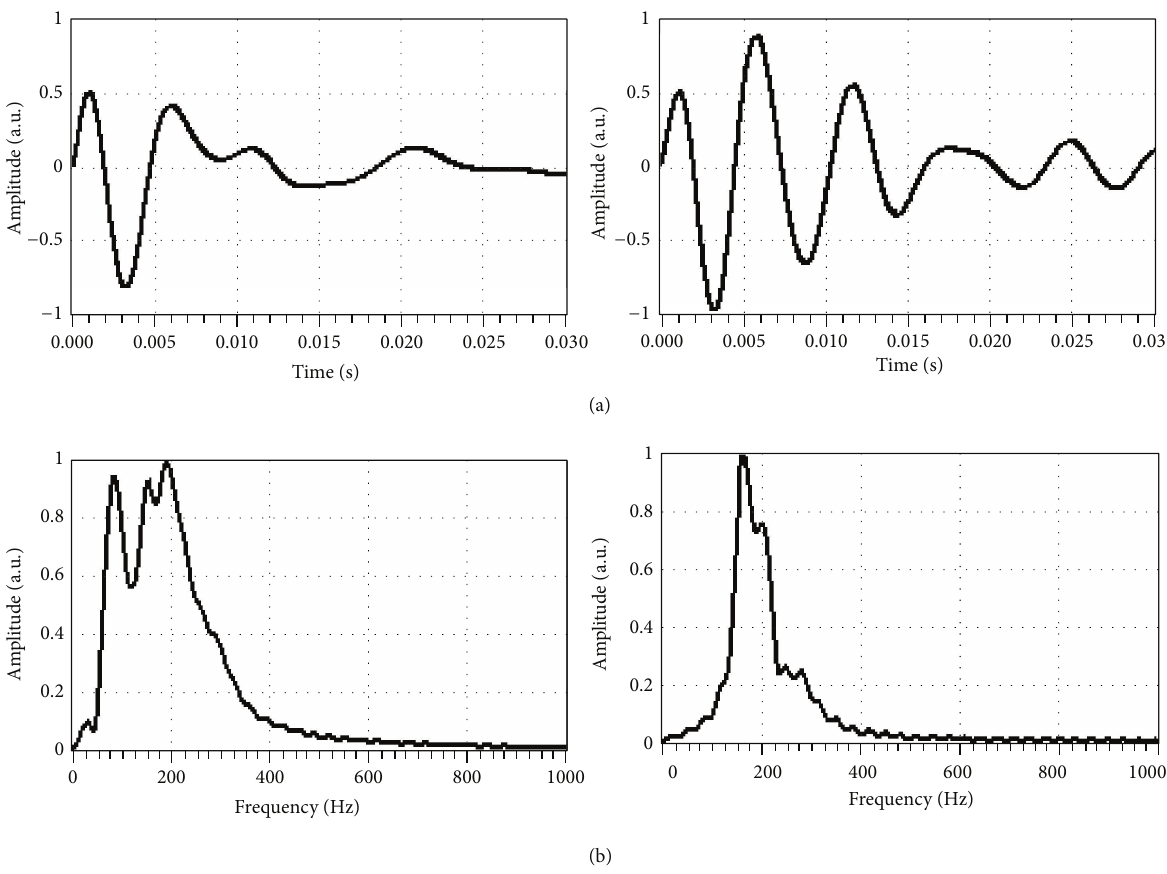
Figure 3: Noise-free “resonant” and “tympanic” percussion signals synthesized with four and three highest-amplitude EDS extracted from the real signals shown in Figure 1. The spectra of both signals are shown in